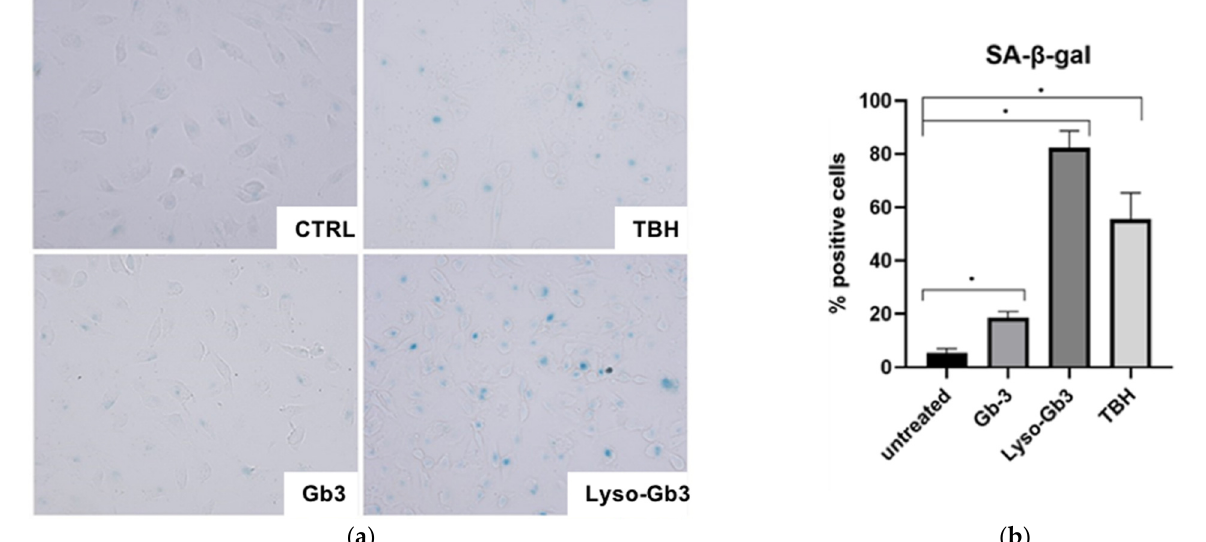
Figure 7. Lyso-Gb3 and Gb3 effect on HUVECs. Intracellular ROS levels and cell viability were assayed in HUVECs treated with TBH 60 µM, Lyso-Gb3 25 nM, and Gb3 10 µM. Intracellular ROS were measured as fluorescence intensity, using a DCFH-DA probe. The results, in arbitrary units (au), are presented as mean ± SD of three different experiments analyzed in triplicate ( a ). Cell viability was evaluated with MTS assay. The results presented as mean % of viable cells ± SD of three different experiments analyzed in triplicate ( b ). Comparison among multiple groups was analyzed by one-way analysis of variance, followed by Bonferroni’s post hoc test. * p < 0.01.